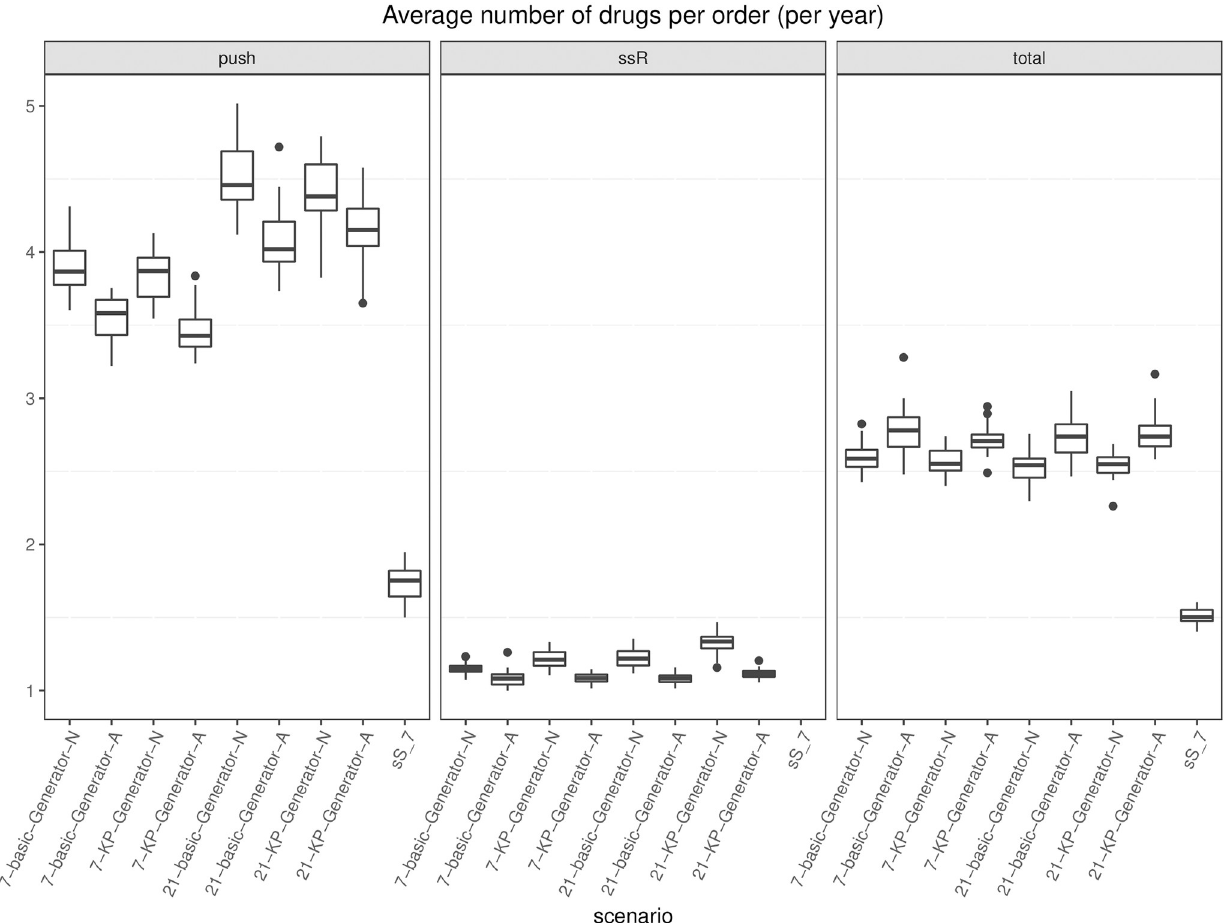
Fig 9. Boxplots of number of drugs (push, replenishment, all). On the left are the boxplots of the average number of drugs in push orders only. In the middle, only safety stock replenishment pull orders are considered, and the average number of drugs in all orders is shown on the right. Each boxplot refers to 30